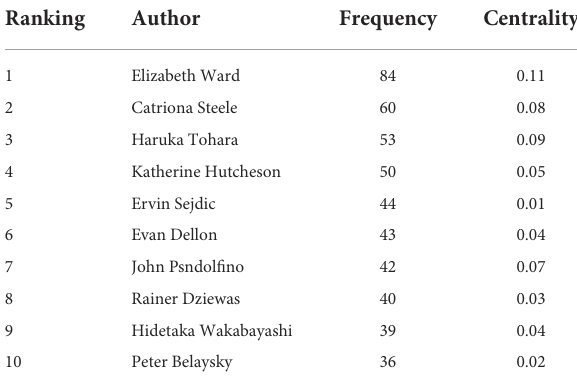
TABLE 3 The top ten productive authors and centrality in the research field of dysphagia from 2012 to 2022.